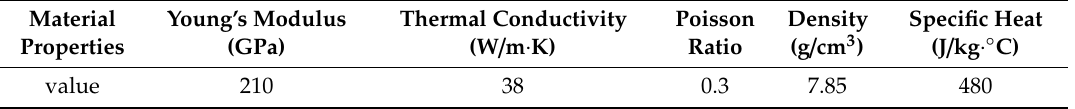
Table 3. Mechanical and physical properties of GCr15 [32,33].